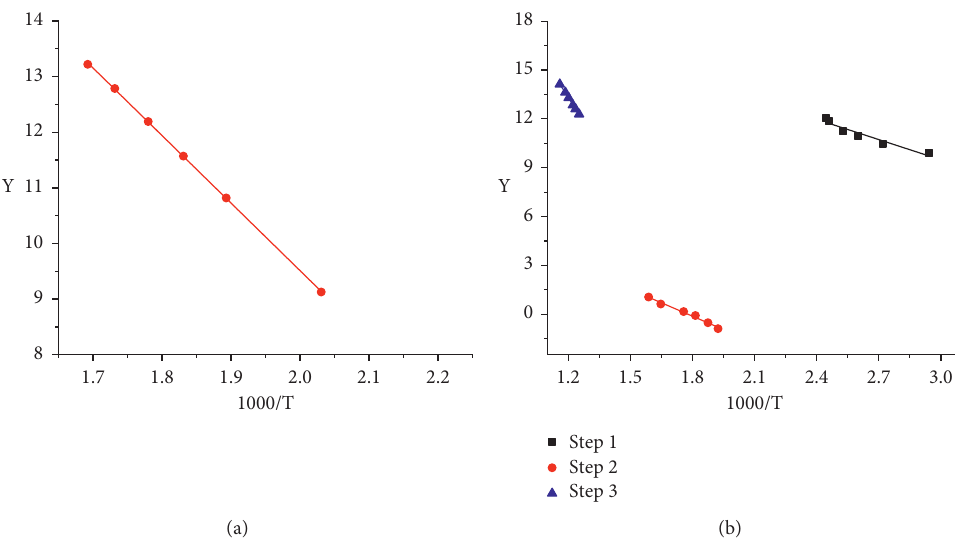
Figure 7: Coats–Redfern plots for the decomposition steps of HL (a) and Al 3+ complex (b). Note: Y � [ 1 − ( 1 − α ) 1 − n ] / ( 1 − n ) T 2 for n ≠ 1 or Y � [− ln ( 1 − α )] / T 2 for n � 1.